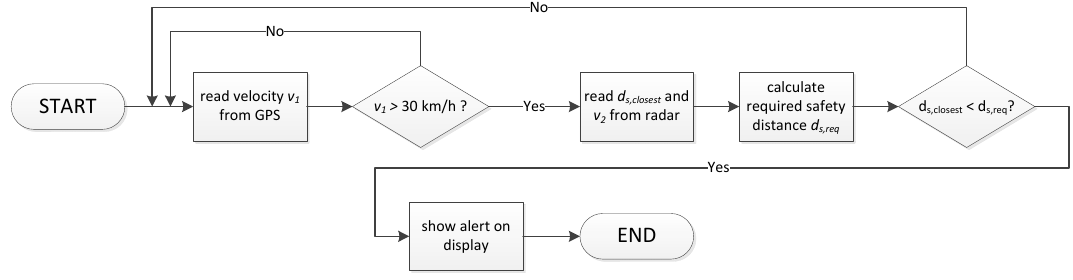
Figure 5. Simplified flow chart of the main subroutine running on the device in an endless loop.